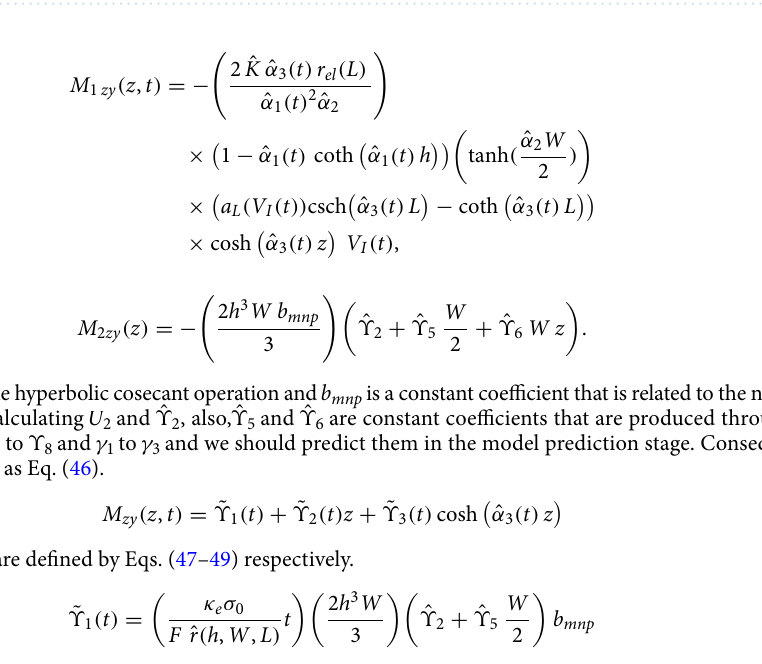
Figure 4. Three possible bending moments for an IPMC beam. ( a ) M zx is exactly zero, ( b ) M zz is almost zero, ( c ) M zy dominates the IPMC bending in the direction of the x